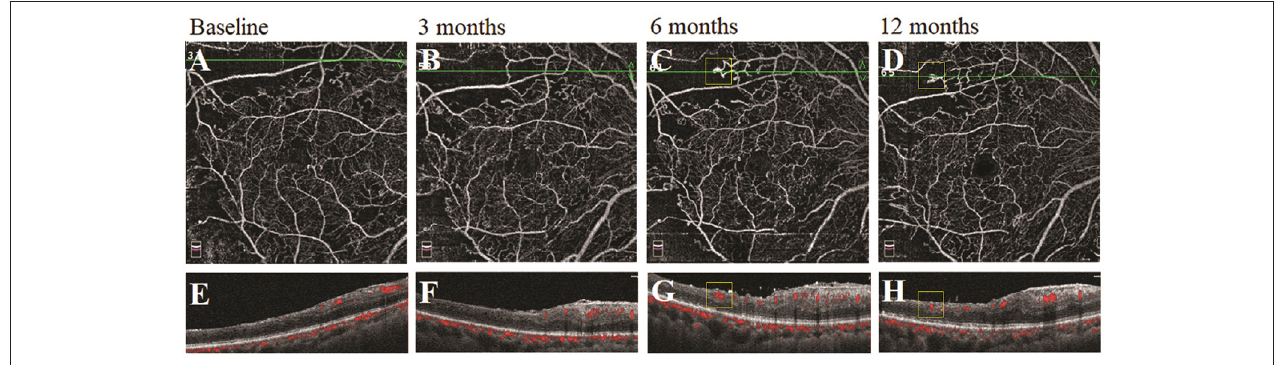
FIGURE 5 | A typical severe nonproliferative diabetic retinopathy (NPDR) case showed the morphological changes of the similar intraretinal microvascular abnormalities (IRMAs) in the nonperfusion area following panretinal photocoagulation (PRP). (A–D) Retina en-face slab images of optical coherence tomography angiography (OCTA). (E–H) B-scan images of